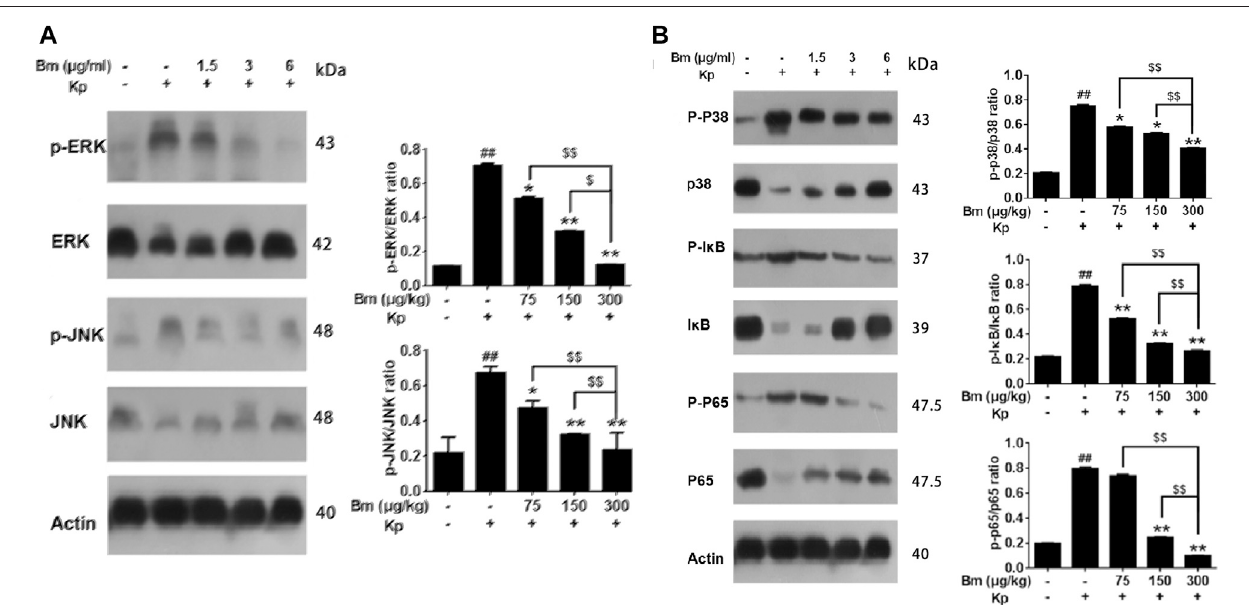
FIGURE 8 | Effects of Bergenin monohydrate (Bm) on the NF- κ B and MAPK pathways in Klebsiella pneumonia -infected mice determined by western blotting. EffectsofB ergeninmonohydrate ontheexpressionofERK,P38andJNKintheMAPKpathwayin Klebsiellapneumonia -infectedmice.Effectsof Bergeninmonohydrate on the expression ofI κ B and P65in the NF- κ B pathway in Klebsiella pneumonia -infected mice (A) Effects on MAPK pathways in Klebsiella pneumonia -infected mice (B) Effects on NF- κ B pathways in Klebsiella pneumonia -infected mice. All data are presented as the means ± SEM ( n (cid:2) 5 in each group). ## p < 0.01 vs the Control group; * p < 0.05 and ** p < 0.01 vs the Klebsiella pneumonia group; $ p < 0.05 and $$ p < 0.01 vs the high-dose